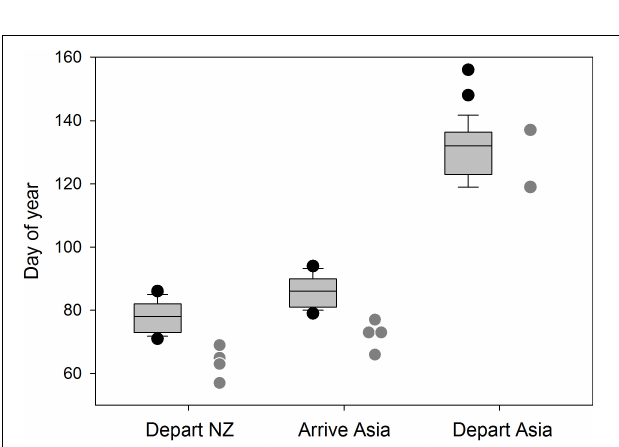
FIGURE 6 | Northward migration timing of geolocator-tracked birds from Manawatu (boxplots) and Otago (gray points) in 2013–2014. Sample sizes are 27 and 4, respectively, for the first two comparisons and 26 and 2 for the third.